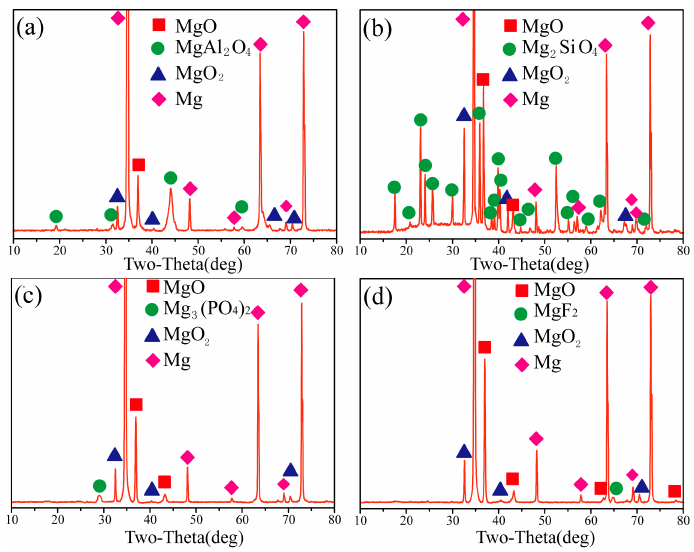
Figure 7. X-ray diffraction (XRD) spectra of PEO coatings. ( a ) Al-coating, ( b ) Si-coating, ( c ) P-coating, ( d ) F-coating.